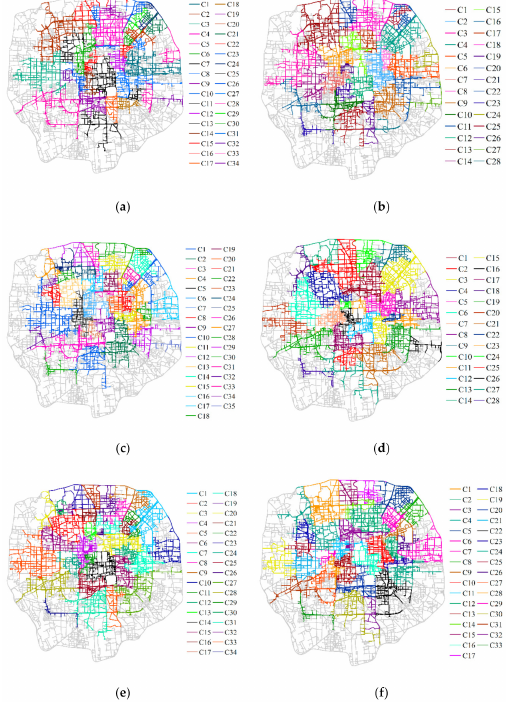
Figure 10. Communities discovered by EACO: ( a ) 8:00–9:00; ( b ) 9:00–10:00; ( c ) 10:00–11:00;